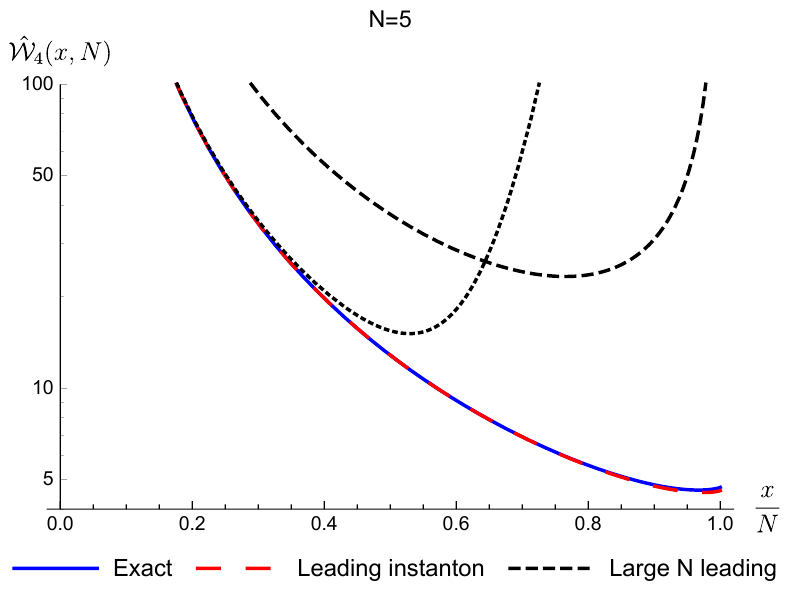
Figure 20 . The solid blue curve shows the exact numerically calculated Wilson loop ^ W 4 (cid:17) 4 (cid:25)N 2 e 2 NS strong W 4 as a function of the inverse ’t Hooft coupling 1 =t (cid:17) x=N . Compare with (cid:12)gure 1 of [53]. The large dashed red curve shows ^ W 4 calculated from the leading approximation for (cid:1) in (5.10) ((cid:1) (cid:25) (cid:1) ). This leading approximation is excellent all the way to the transition point (1) at x = N . The black curves with medium and small dashes show ^ W 4 calculated from the one- instanton series in the large N strong coupling expansion (5.38) with just the leading term and the (cid:12)rst (cid:12)ve terms, respectively (see for example, expression (4.8) in [53]). The latter plot agrees well at very small x (very strong coupling) but diverges well before the transition point. All quantities are calculated at N =